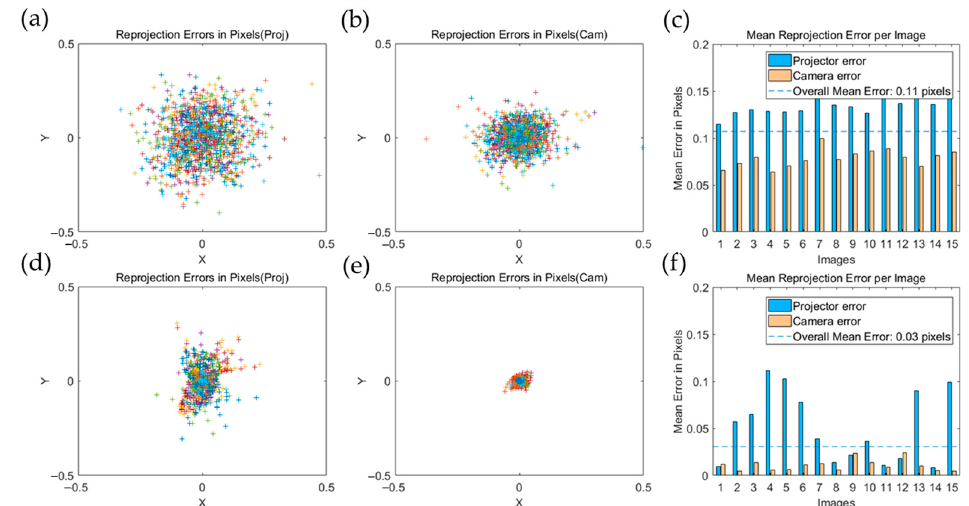
Figure 7. The re ‐ projection error: ( a ) of a projector before the BA algorithm, ( b ) of the camera before the BA algorithm, ( c ) of 15 random poses before the BA algorithm, ( d ) of the projector after the BA algorithm, ( e ) of the camera after the BA algorithm, and ( f ) of 15 random poses after the BA algo ‐ rithm.